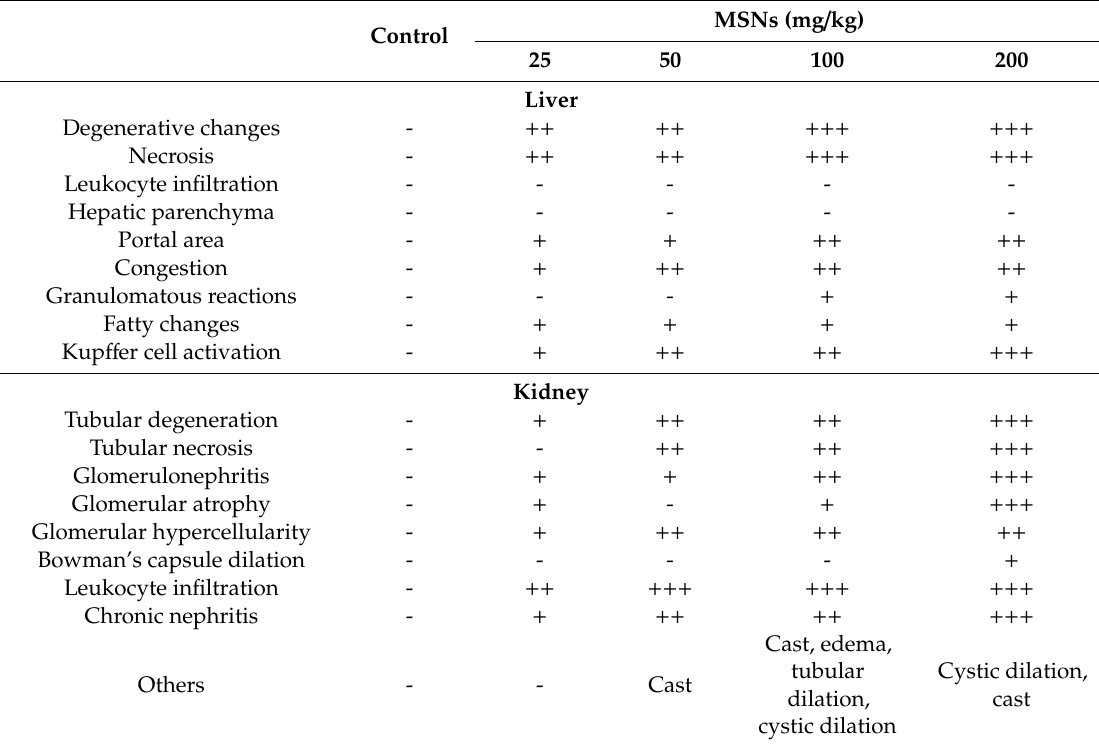
Table 3. Histopathological alterations in liver and kidney of MSNs-induced